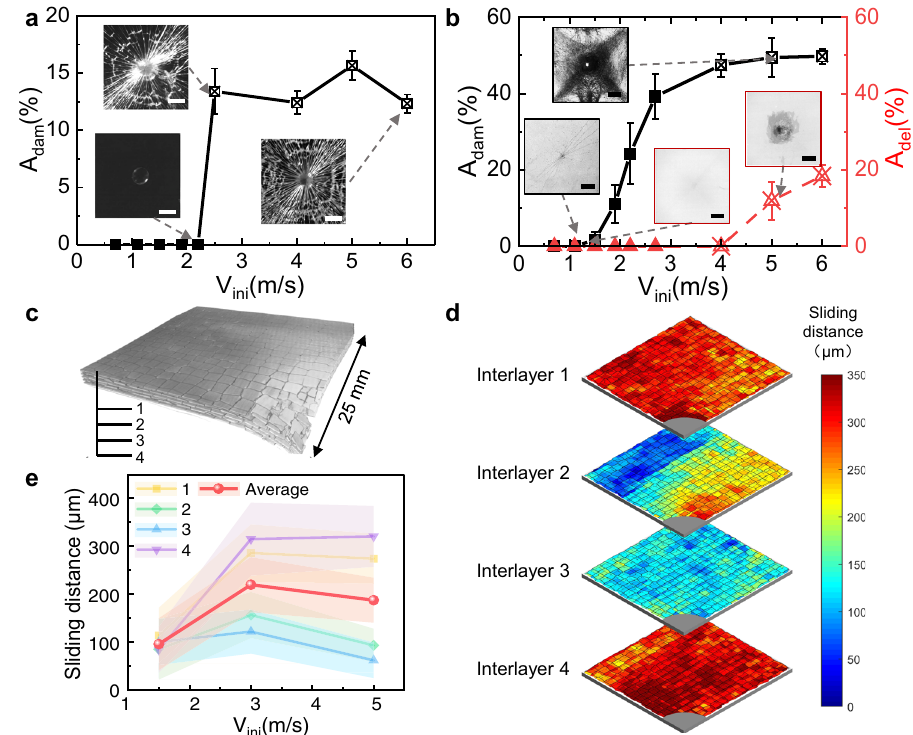
Fig.3|Energydissipationmodesfornacre-likestructuresandotherstructures under different V ini . a The proportion A dam of fracture area for the monolithic sample under different V ini . The insets show the damage patterns of the impacted samples. Scale bar: 10mm. b The A dam in hard layers and the proportion A del of delamination area in soft phase for the laminatedsamples underdifferent V ini . The